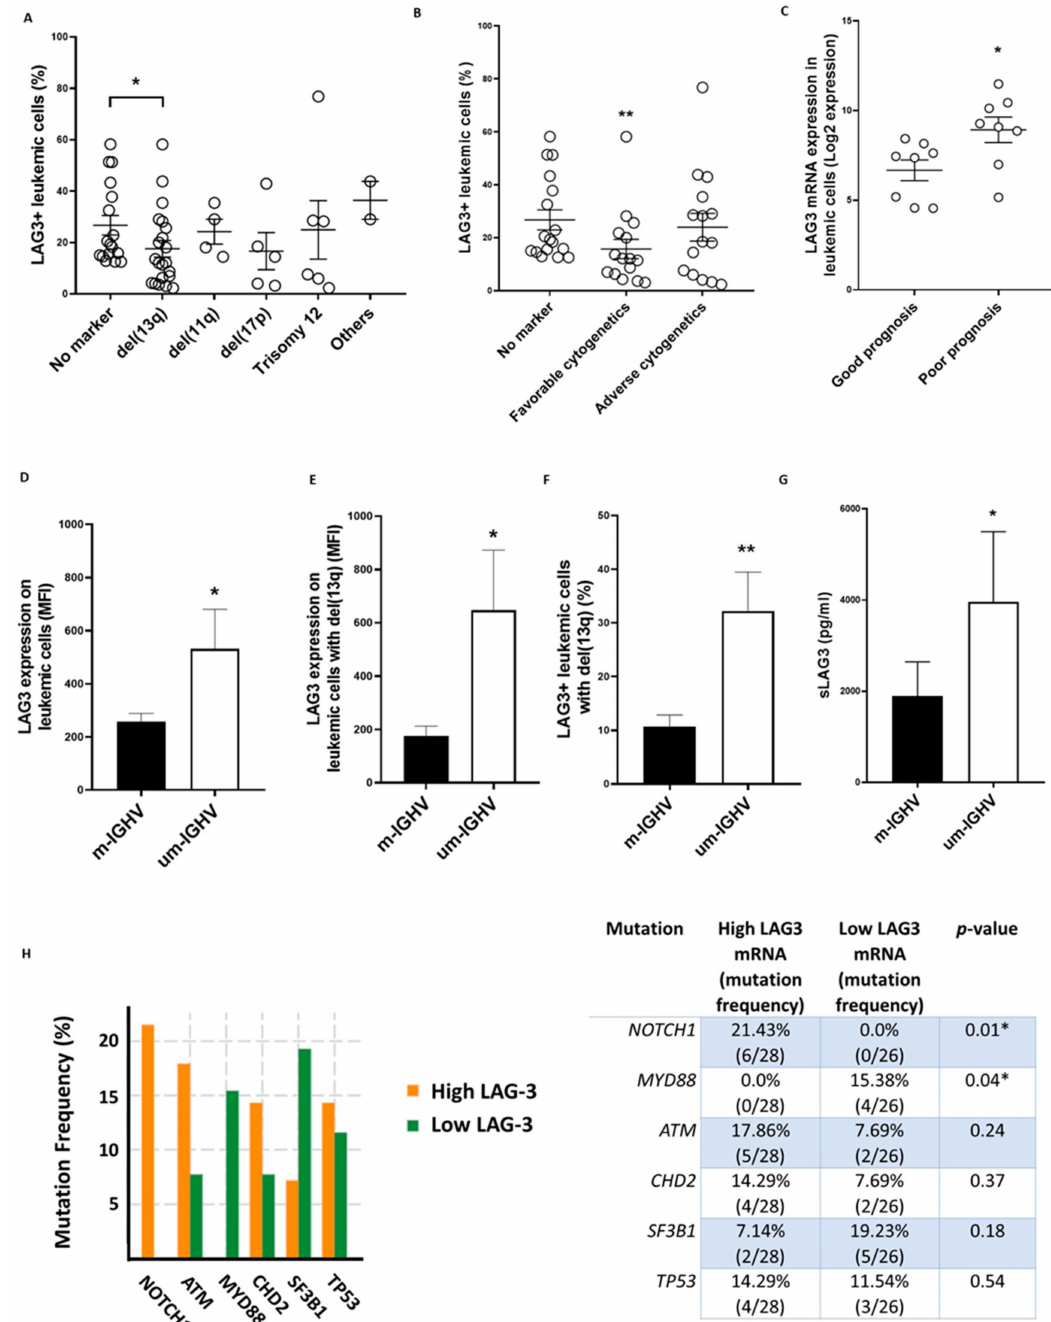
Figure 2. LAG-3 expression correlates with prognostic factors in CLL. ( A ) LAG-3 surface expression was evaluated on leukemic cells from patients with CLL ( n = 61) categorized by cytogenetics abnormalities by flow cytometry; ( B ) LAG-3 surface expression on leukemic cells in patients stratified by cytogenetics abnormalities ( n = 61): no marker (no abnormalities), favorable cytogenetics (del(13q)) and adverse cytogenetics (patients with del(11q), del(17p) and/or trisomy 12 owing or not del(13q)) is shown; ( C ) In silico analysis (GSE4392) of LAG3 mRNA expression in leukemic cells from ZAP70-CD38- (good prognosis) and ZAP70+CD38+ (poor prognosis) patients; ( D – G ) Evaluation of LAG-3 expression on leukemic cells from patients with mutated (m-IGHV) or unmutated (um-IGHV) IGHV ; Comparison of LAG-3 expression patients (MFI ± SEM) ( E ) and percentage ( F ) in patients with del(13q) are shown ( n = 61); ( G ) Sera levels of sLAG-3 in 28 patients with mutated and unmutated IGHV status are depicted; ( H ) In silico analysis of LAG3 mRNA expression in patients stratified by driver mutations in CLL using cBioportal. * p < 0.05 and ** p <